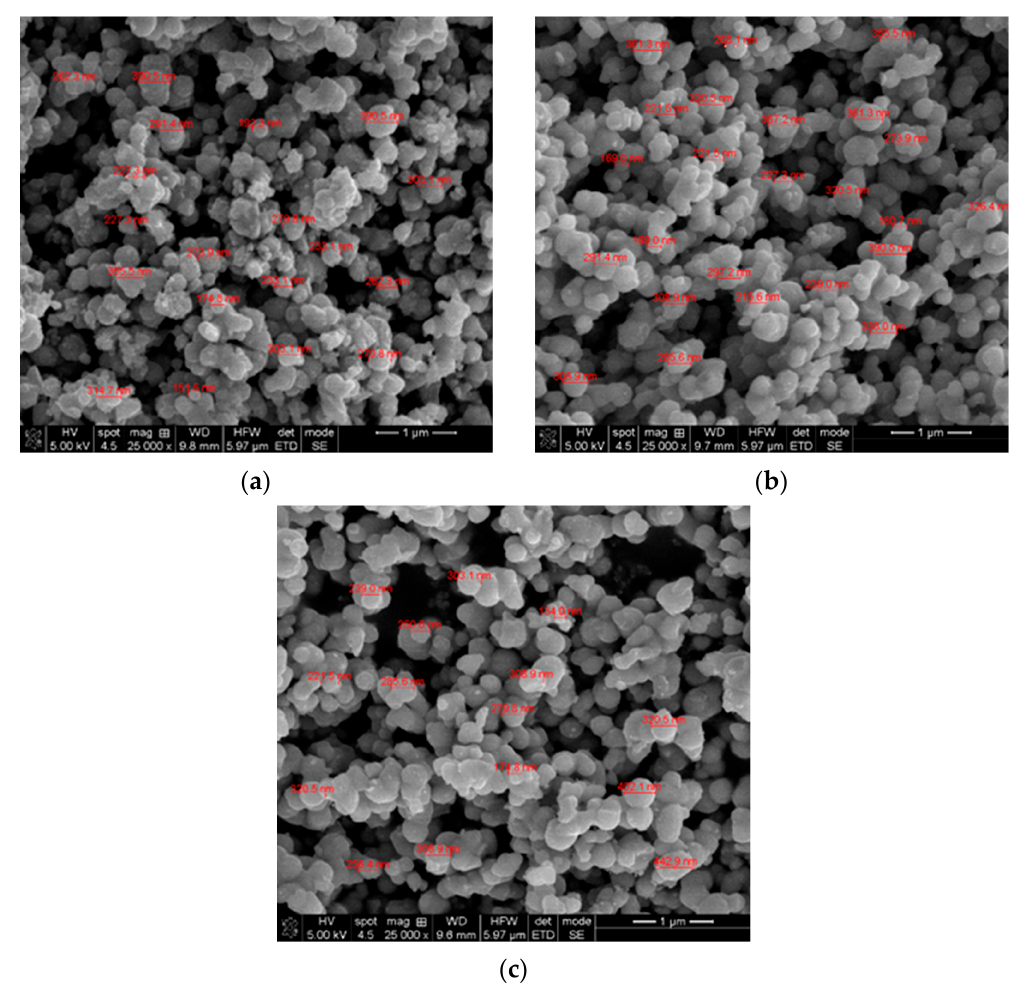
Figure 1. SEM micrographs of the as-prepared samples; ( a ) TiO 2 MW, ( b ) TiO 2 − Cu 2.0% MW, ( c ) TiO 2 − Zn 2.0% MW.